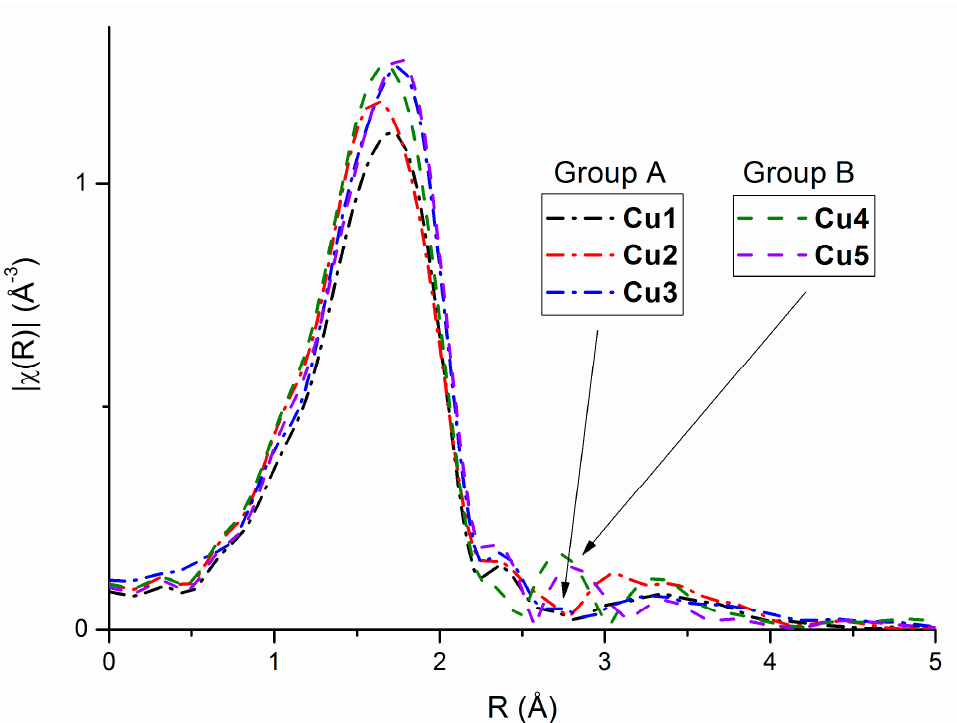
Figure 6. Fourier transformed experimental EXAFS oscillations for complexes.